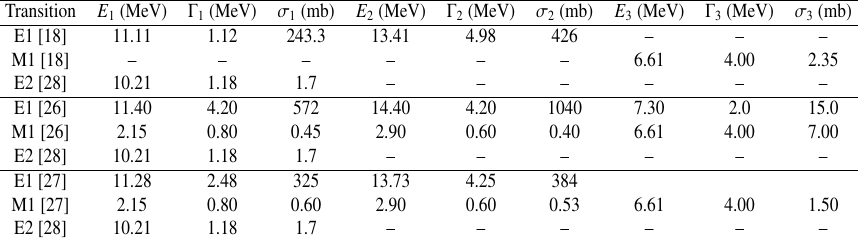
Table 1. Parameters from RIPL-3 [18], OCL [26] and DANCE [27] for the